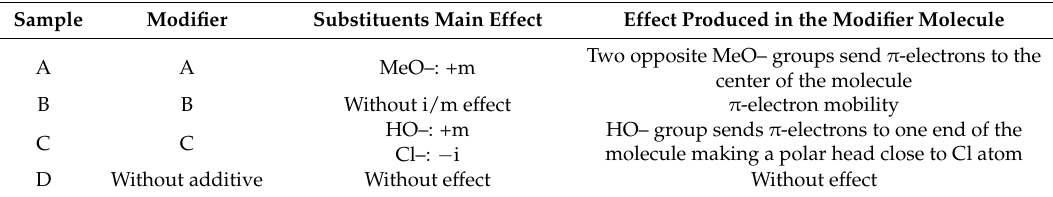
Table 2. Effect produced in the additive molecule by the substituents.